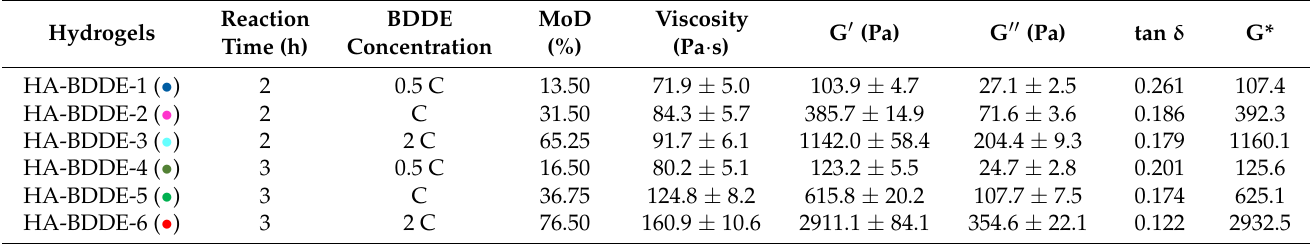
Table 1. MoD and viscoelastic features of the produced HA-BDDE